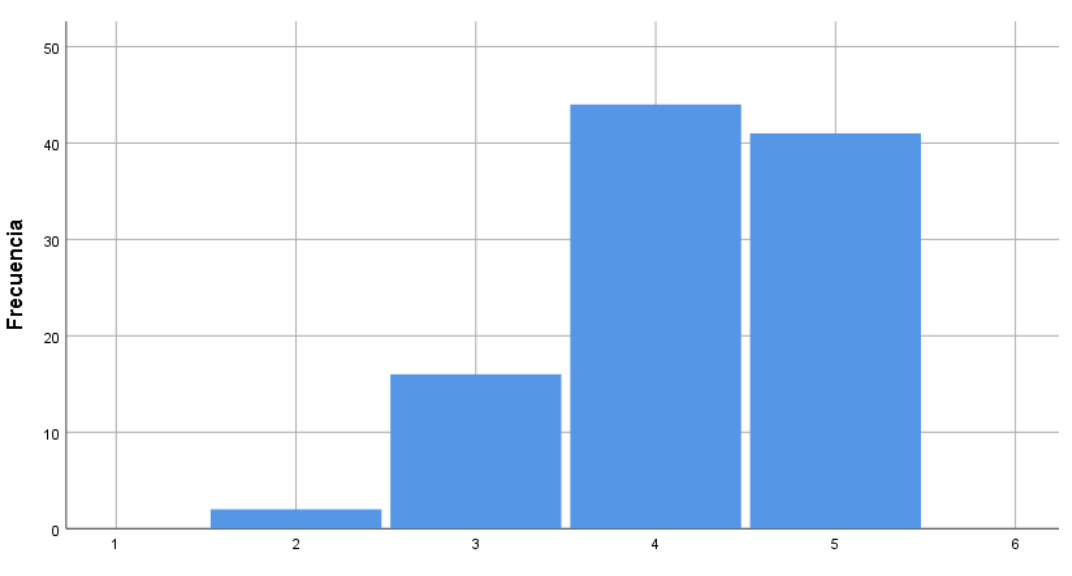
Figure 3. Strong and weak points of the educational centre for attending to diversity.